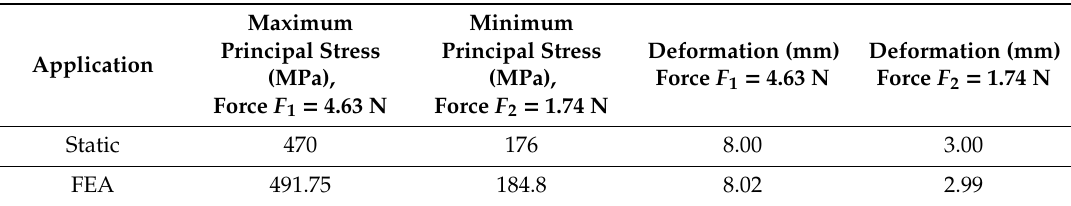
Table 3. Static Analysis Results using the theories of failure for ductile